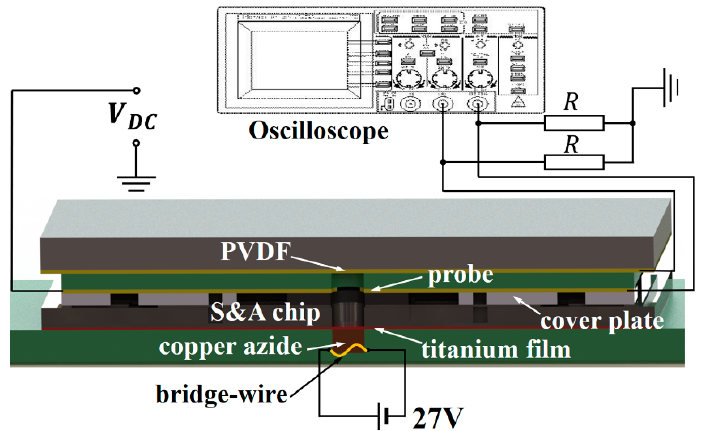
Figure 17. The system for the flyer velocity measurement.